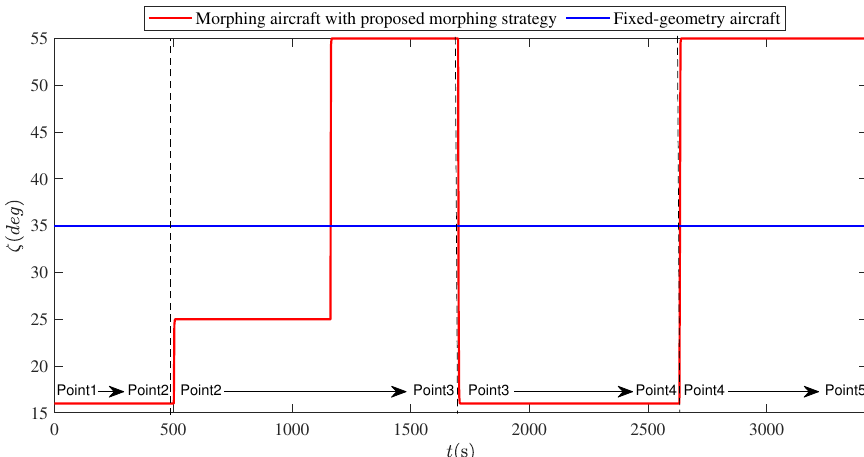
Figure 13. ζ of the comparative simulation in Section 5.1.